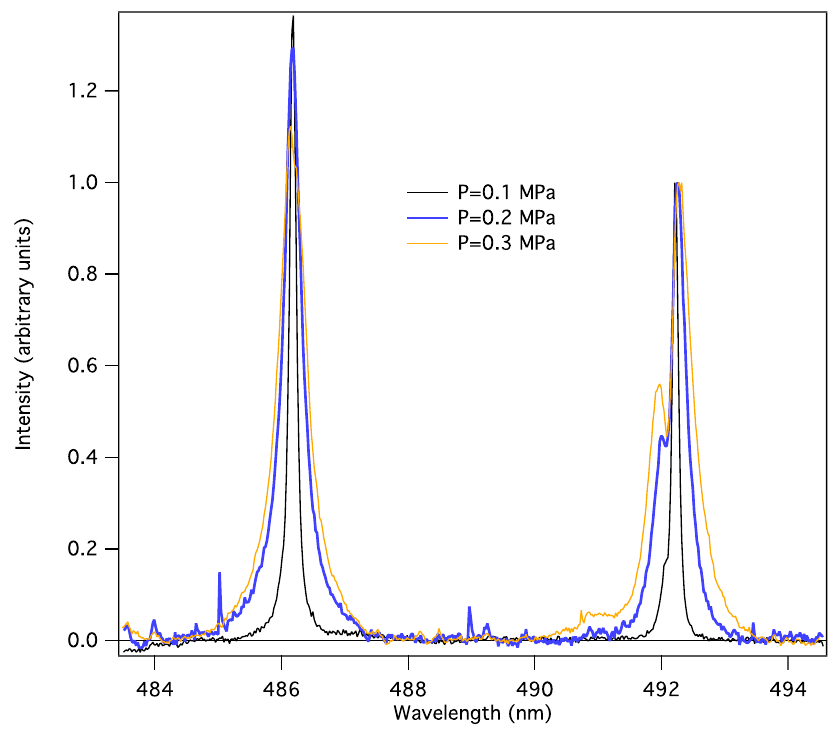
Figure 5. Experimental spectra of H-β and He I 492 nm lines measured at 0.1, 0.2, and 0.3 MPa.